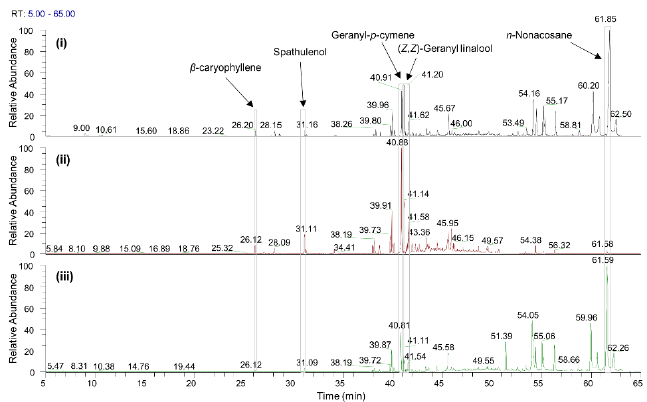
Figure 1. Gas chromatography-mass spectrometry (GC-MS) chromatograms of ( i ) dichloromethane (DCM) extract, ( ii ) essential oil (EO), and ( iii ) supercritical fluid extract (SFE) obtained from S. sipylea .